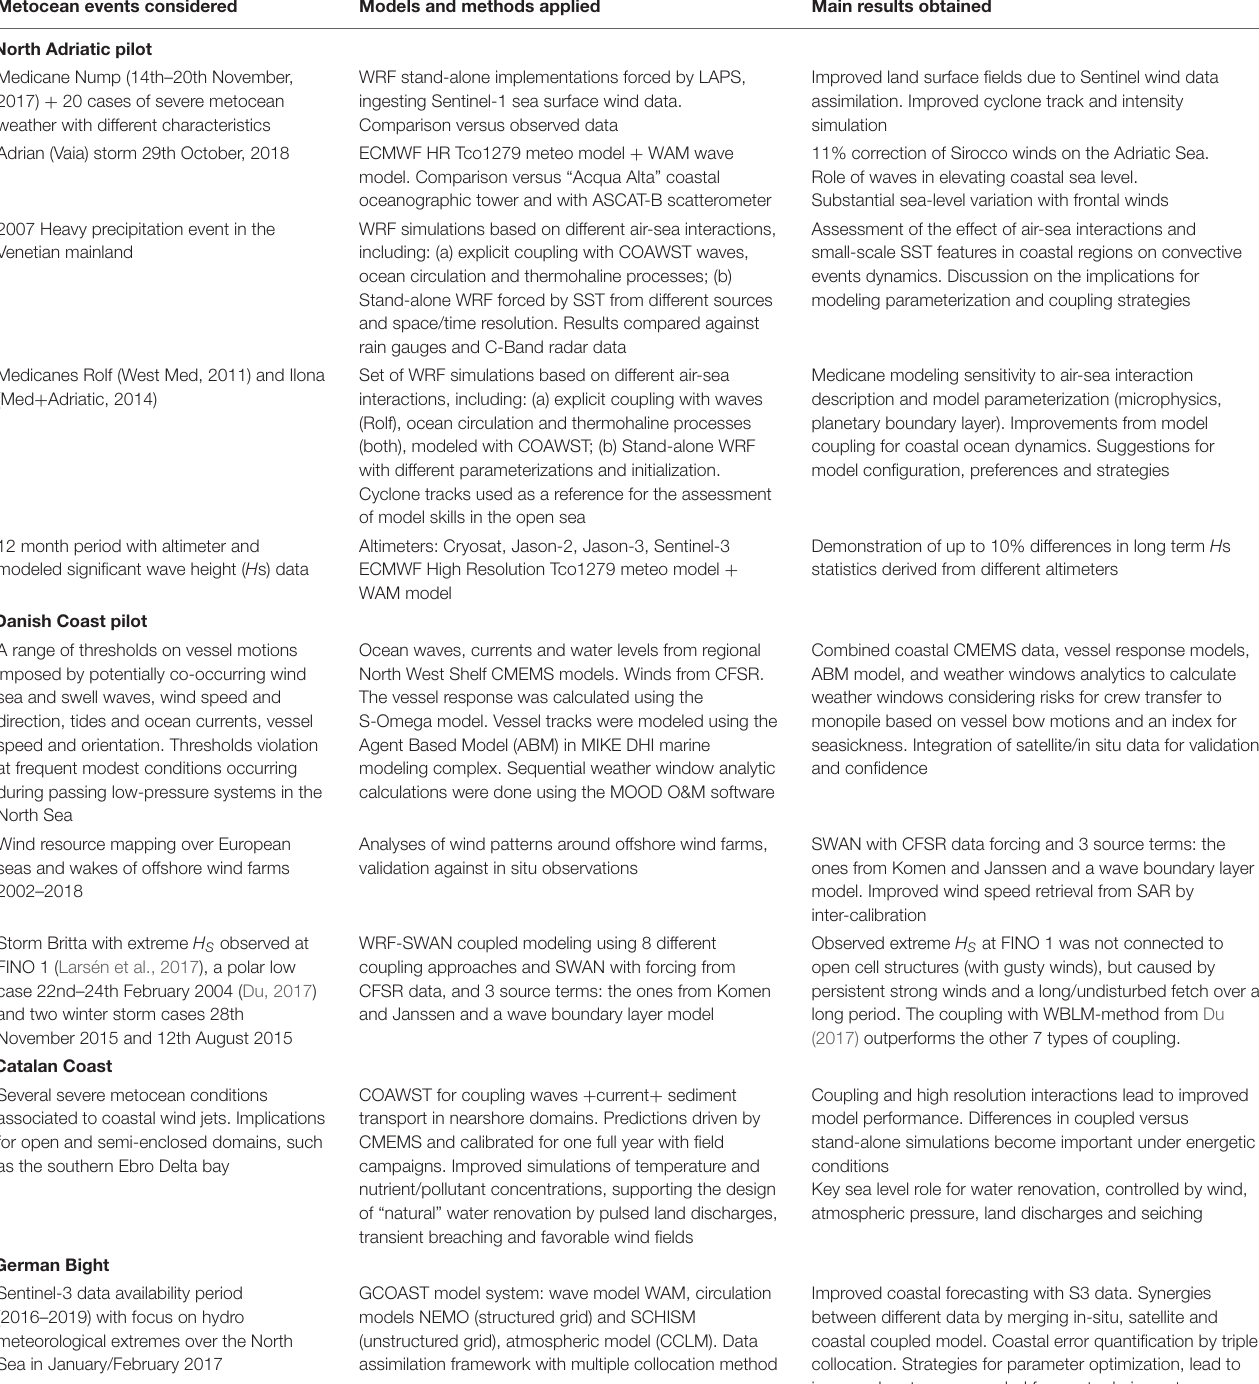
TABLE 1 | Summary of main metocean events considered at each CEASELESS pilot site, together with the models applied to analyze these events and the main results obtained. Metocean events